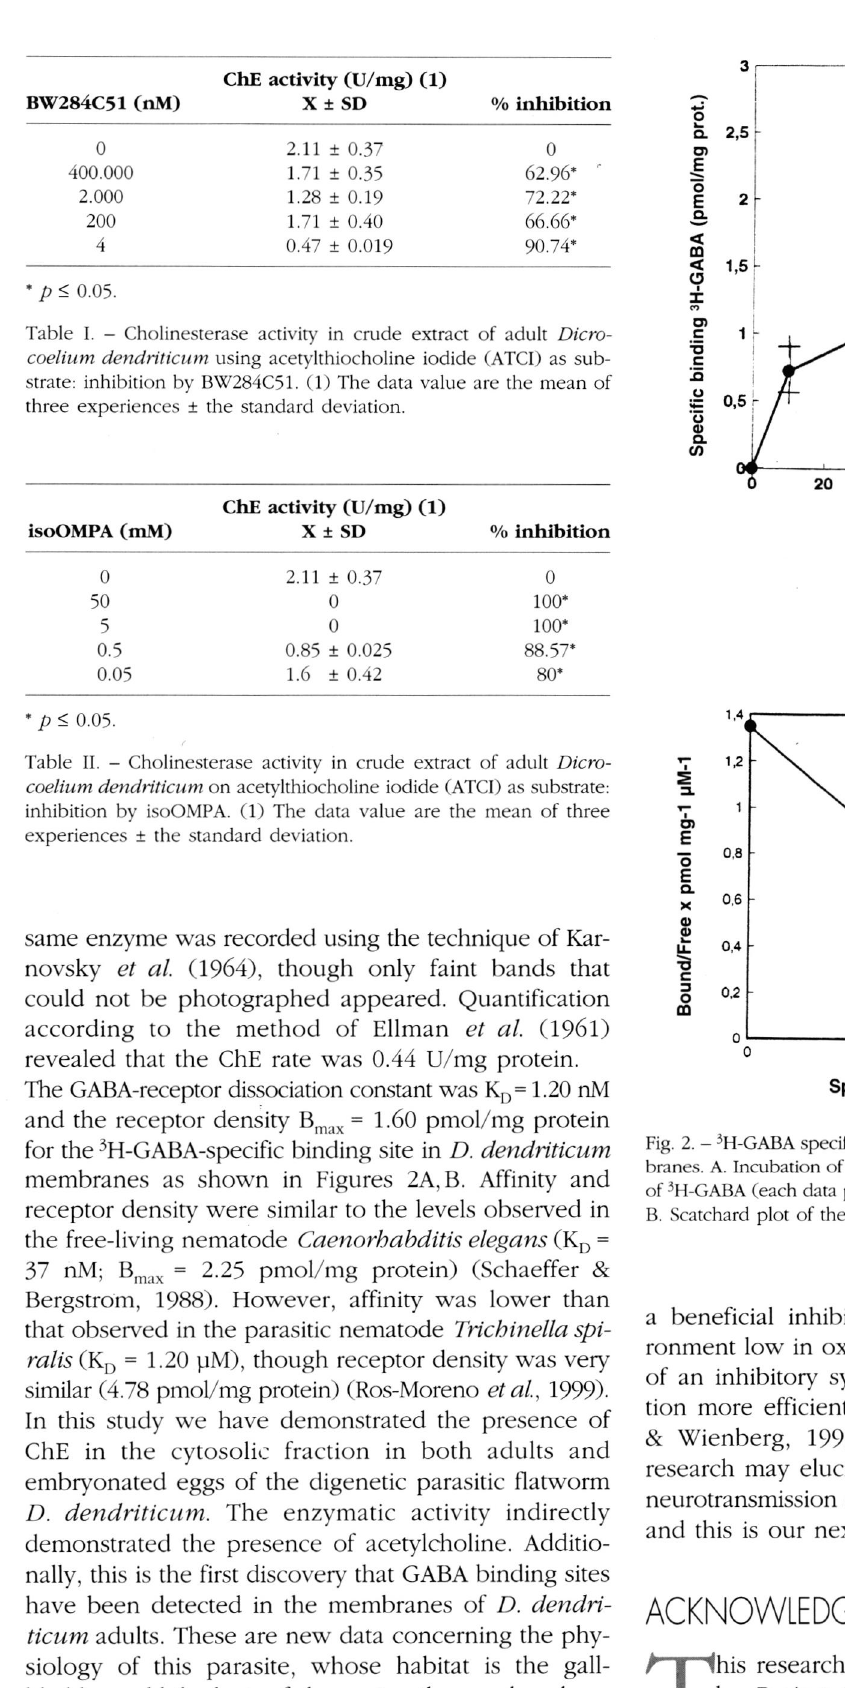
Table I. - Cholinesterase activity in crude extract of adult Dicro coelium dendriticum using acetylthiocholine iodide (ATCI) as sub strate: inhibition by BW284C51. (1) The data value are the mean of three experiences ± the standard deviation.